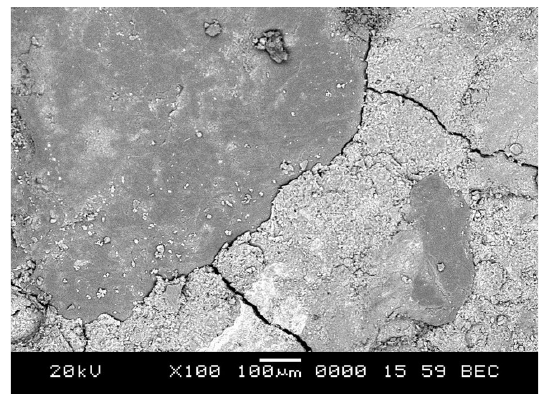
Fig. 7. SEM micrograph (backscattered electron image) showing T-shaped cracks